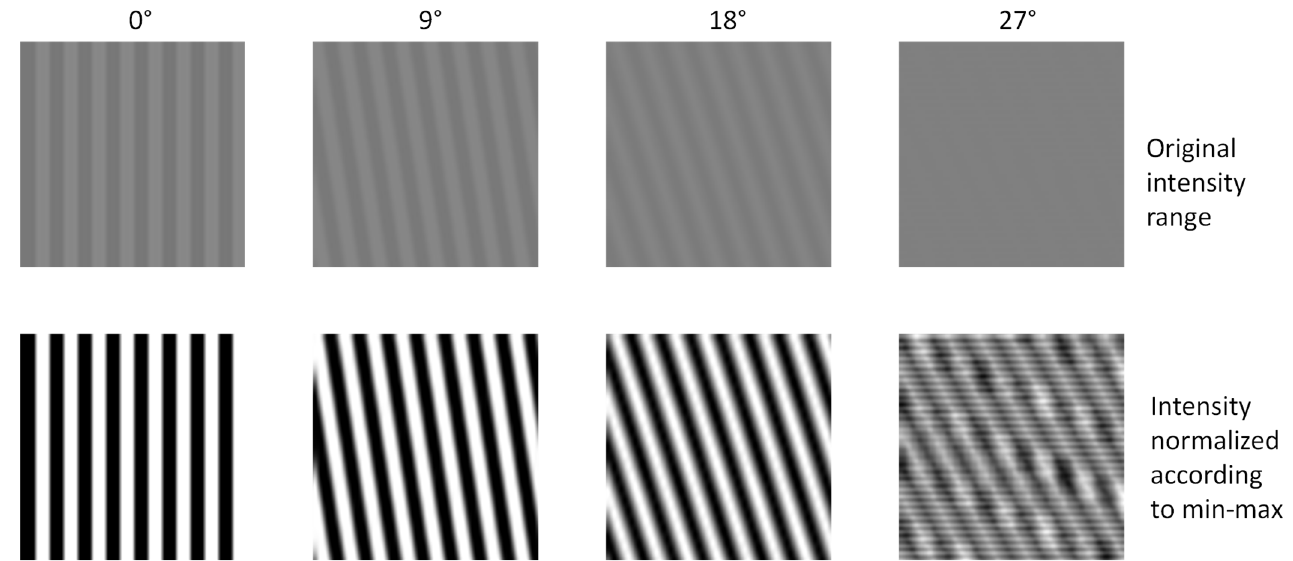
Figure 11. Instance of bars of bar size 4, bar period 8 and blurred by averaging filter with kernel size of 9 × 9.